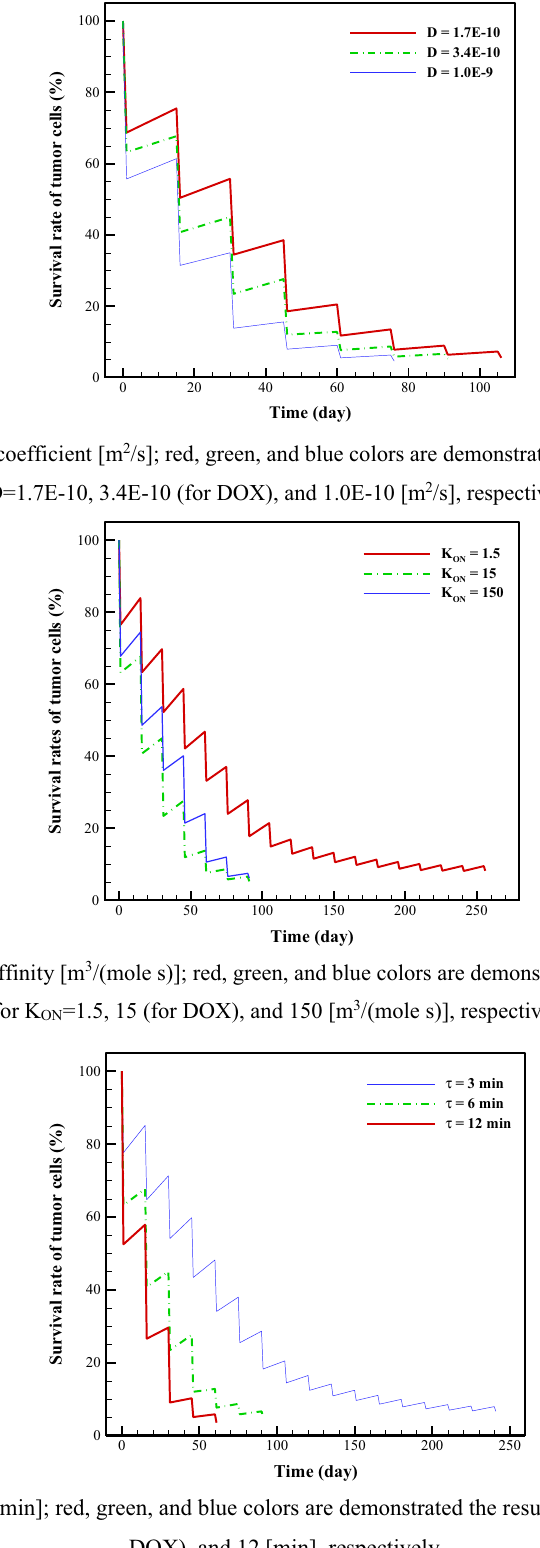
DOX), and 12 [min], respectively. Figure 4. Survival rate of tumor cells for different ( a ) diffusion coefficients, ( b ) binding affinities, ( c ) half-lives. Parameter study of these three properties is performed to examine their impacts on drug delivery and treatment. To this aim, a baseline state is investigated with the same treatment plan for the different states considered, and then the values for the different parameters are changed. The baseline state is related to drug DOX and the other parameters are related to theoretical chemotherapeutic drugs. These parameter values are extracted from the measured values for DOX, as they have not been measured for most other clinical chemotherapy drugs. The ranges for different parameters were created to encompass most possible physical